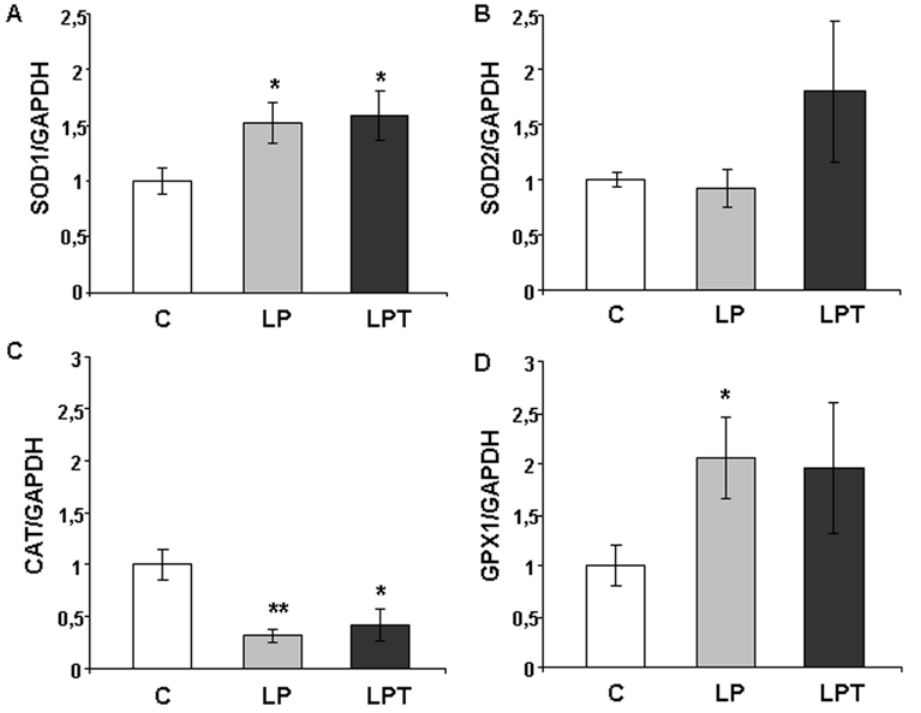
Figure 5. SOD1 (A), SOD2 (B), CAT (C), GPX1 (D) gene expression in pancreatic islets from 3 month-old rats. Results are expressed as means 6 SEM; n=6–7 independent experiments. *p , 0.05, **p , 0.01 vs C;